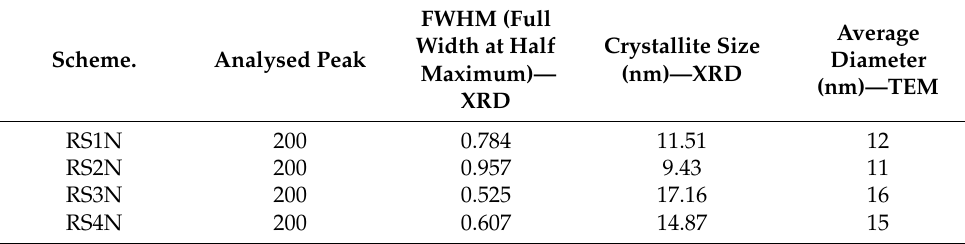
Figure 1. X-ray diffractograms of the obtained nanoparticles. Peaks marked with “*” are due to the presence of silver oxide. Table 2. Analysis of XRD and TEM data.